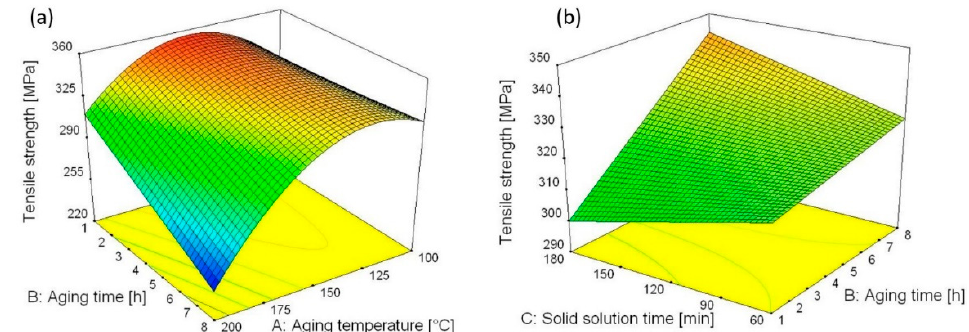
Figure 5. ( a ) Influence of aging temperature and aging time on tensile strength of SSR samples for constant solid solution time at 60 minutes ( b ) Influence of solid solution time and aging time on tensile strength of SSR samples for constant aging temperature at 100 °C.